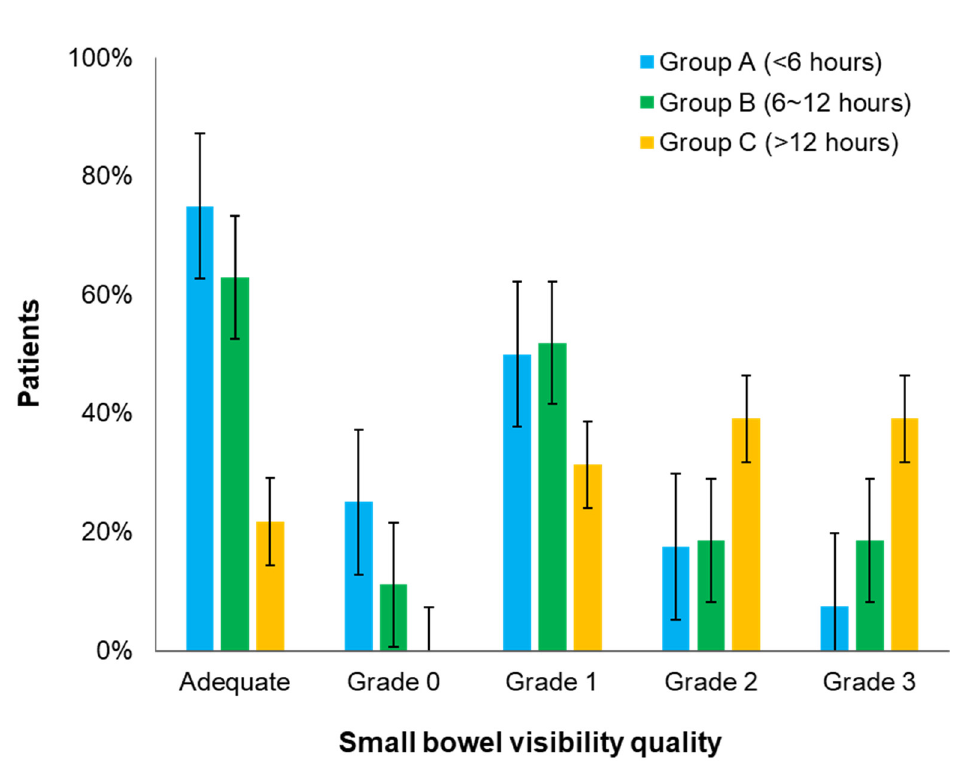
Figure 5. Comparison of small bowel visibility quality (SBVQ) according to the timing of bowel preparation.